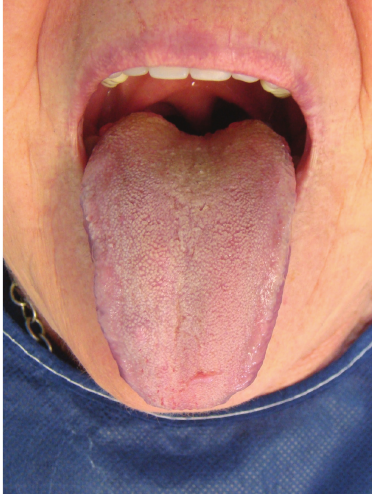
Figure 2: Complete response after only one treatment